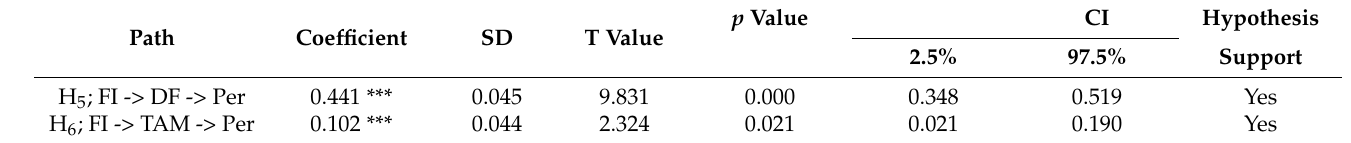
Table 8. Indirect